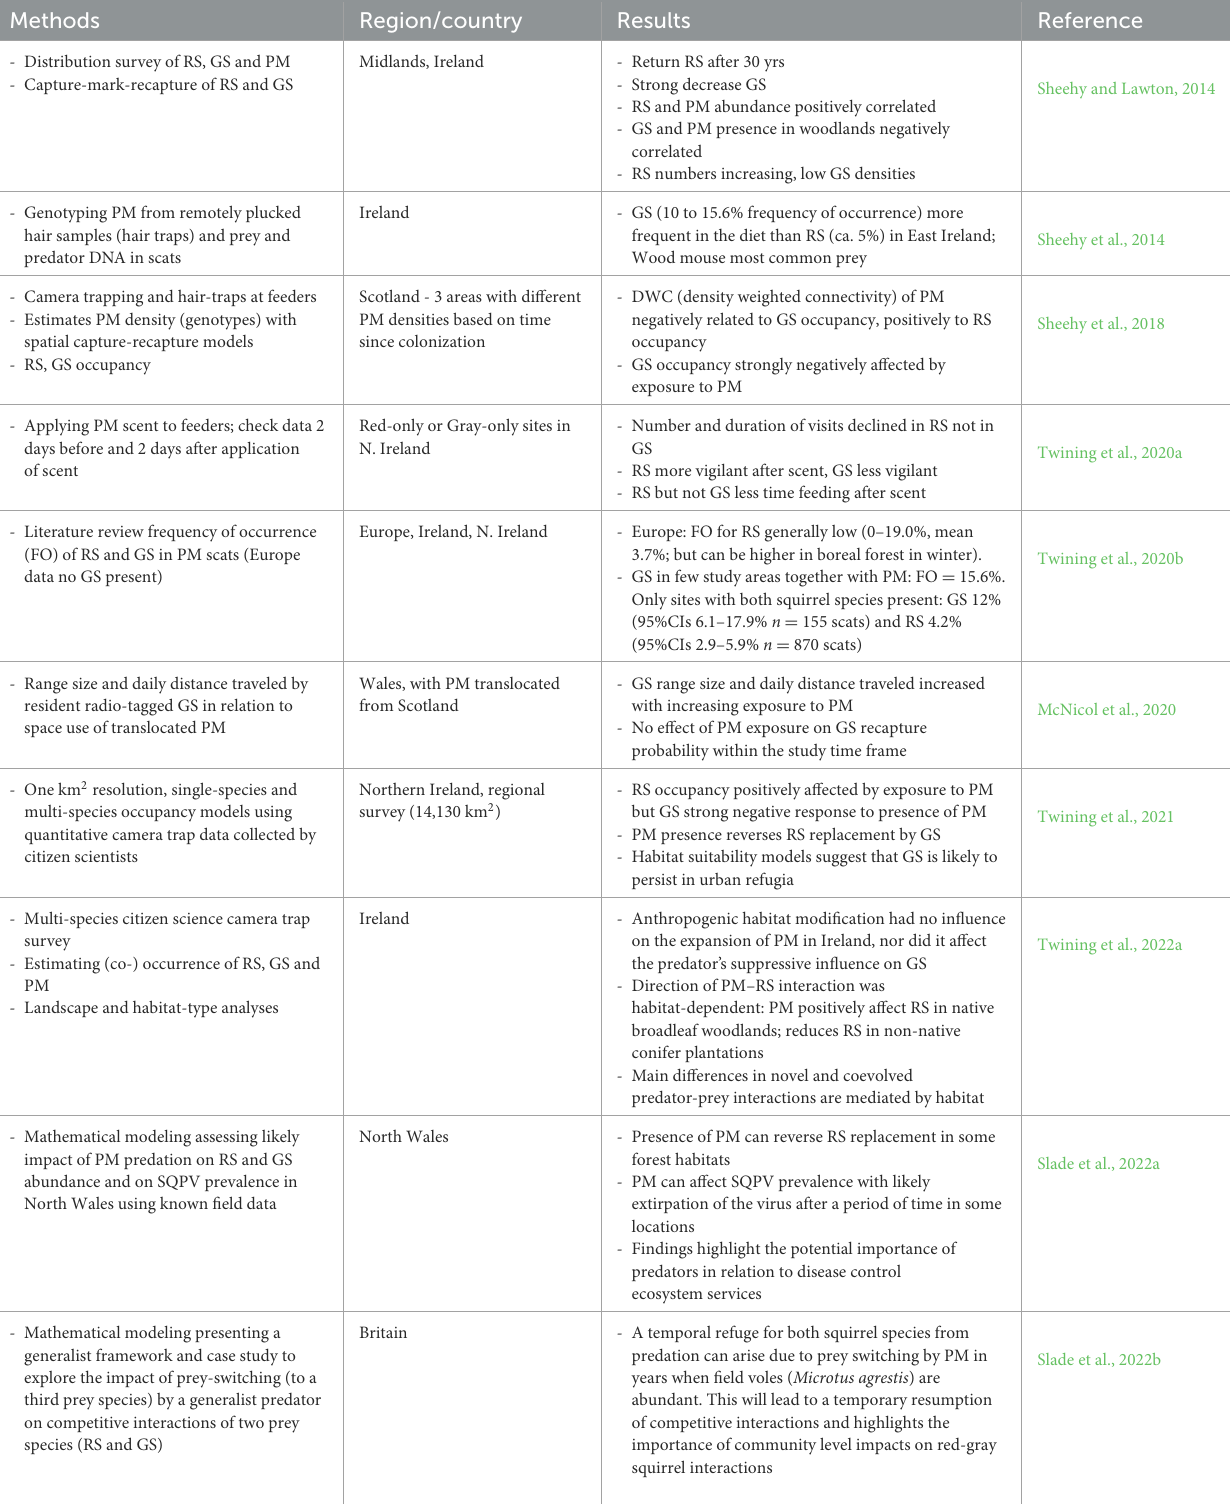
TABLE 1 Summary of studies in Britain and Ireland that support the role of pine marten in the outcome of predator-mediated competition between red and gray squirrels.